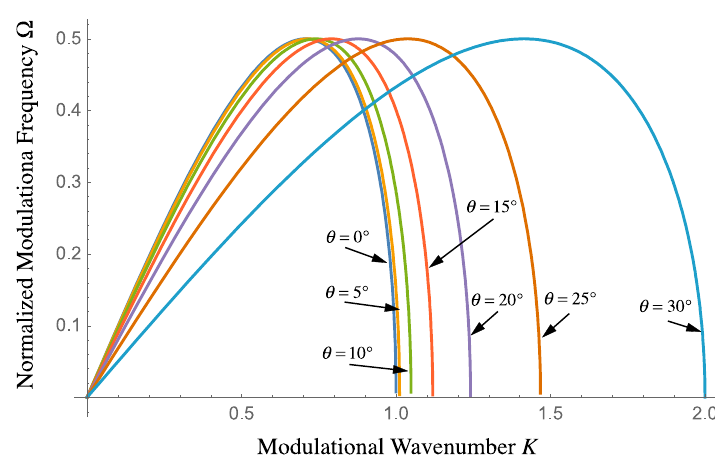
Figure 11. Instability diagram for the rotated 1 + 1 NLS equation as a function of the modulational wavenumber. Several curves are given for di ff erent rotation angles. Figure 12. Instability diagram surface for the rotated 1 + 1 NLS equation as a function of the modulational wavenumber and the rotation angle.